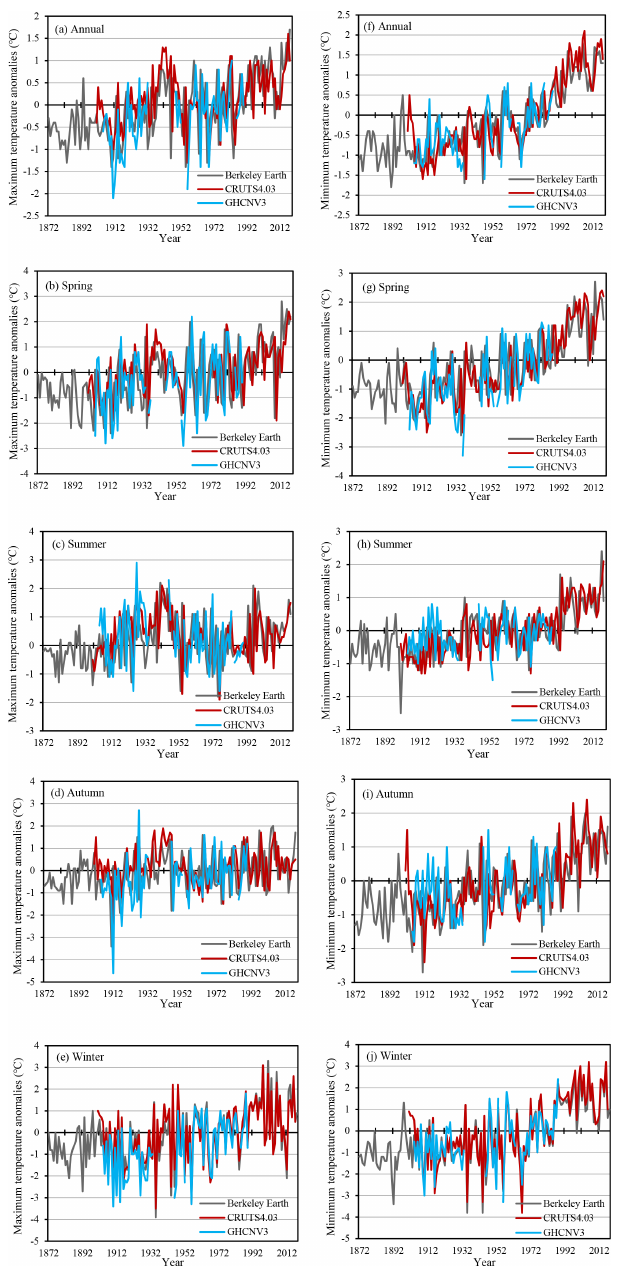
Figure 3. The annual and seasonal average anomalies of maximum (a–e) and minimum (f–j) temperatures based on the interpolated series of BE and CRU TS4.03 and the station series of GHCN v3 for Tianjin